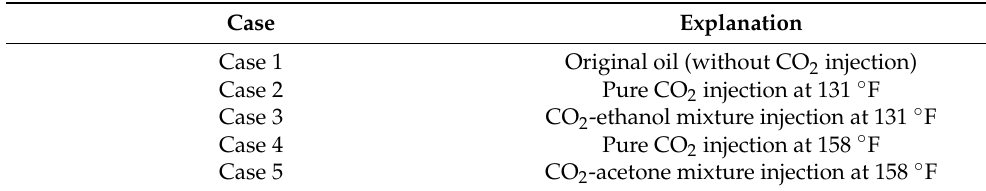
Table 3. Case studies and their